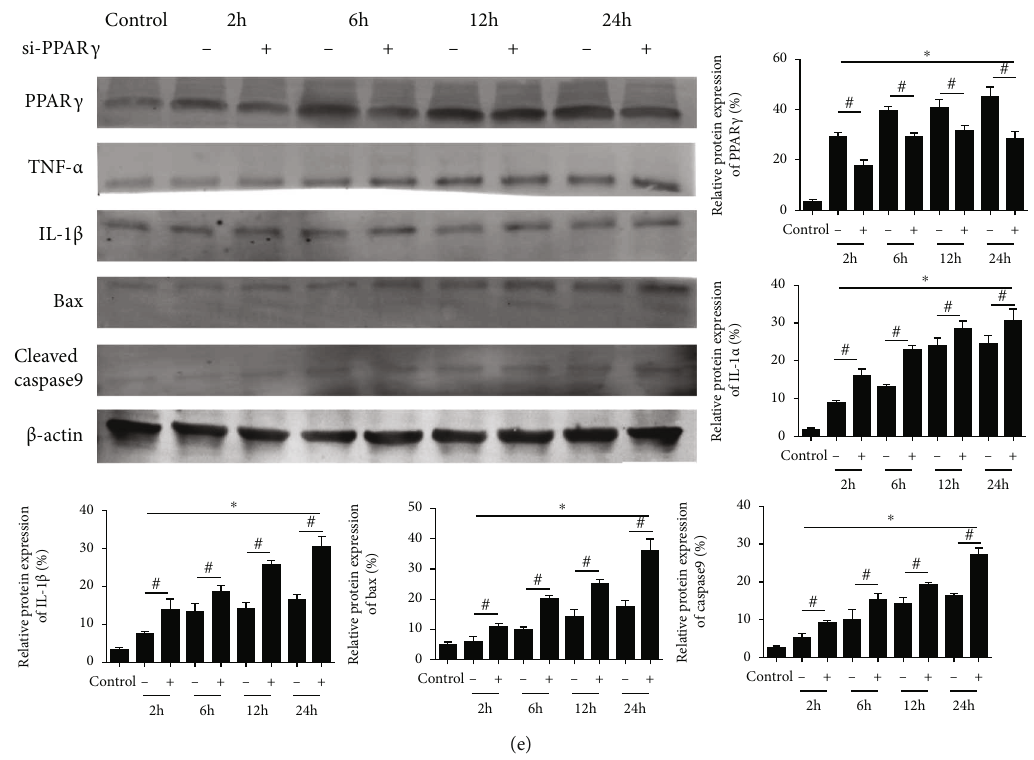
Figure 2: E ff ect of PPAR γ alleviation on liver function and pathology of mice in IR. Notes: (a) the levels of serum ALT and AST ( n = 5 , ∗ means p < 0 : 05 for si-PPAR γ versus IR after 2, 6, 12, and 24h, + means p < 0 : 05 for IR verse control); (b) the levels of serum TNF- α and IL-1 β ( n = 5 , ∗ means p < 0 : 05 for si-PPAR γ versus IR after 2, 6, 12, and 24h, + means p < 0 : 05 for IR verse control); (c) relative mRNA expression of TNF- α ( n = 5 , # means p < 0 : 05 for si-PPAR γ versus IR after 2, 6, 12, and 24 h, + means p < 0 : 05 for IR verse control); (d) relative mRNA expression of Bax ( n = 5 , # means p < 0 : 05 for si-PPAR γ versus IR after 2, 6, 12, and 24h, + means p < 0 : 05 for IR verse control); (e) protein expression of PPAR γ , TNF- α , IL-1 β , Bax, and cleaved caspase9 ( n = 3 , # means p < 0 : 05 for si-PPAR γ versus IR after 2, 6, 12, and 24 h, ∗ means p < 0 : 05 for IR verse